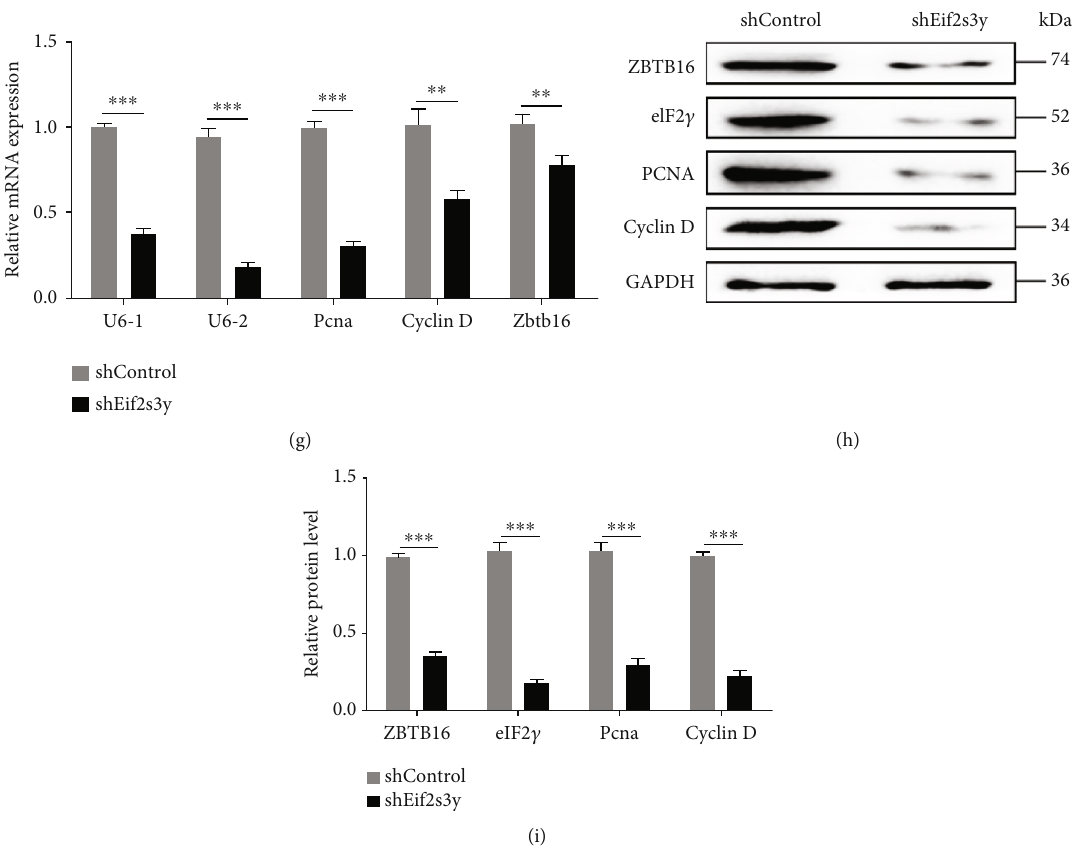
Figure 4: Depletion of Eif2s3y resulted in proliferation abnormality in goat SSCs. (a, b) The schematic of lentivirus plasmid CD513B-U6-MCS and CD513B-U6- shEif2s3y . (c) Typical images of shControl (left) and shEif2s3y (right) SSCs. Scale bar, 200 μ m. (d) Proliferation curve of shControl and shEif2s3y SSCs and the results of population doubling time (PDT) determination. (e) EdU incorporation assay of shControl (up) and shEif2s3y (down) SSCs. Scale bar, 400 μ m. (f) The ratio of EdU-positive cells to total cells. Data are presented as mean ± SD and are represented by three independent repetitions. (g) RT-PCR analysis of the expression levels of Eif2s3y , Pcna , Cyclin D, and Zbtb16 in shControl and shEif2s3y SSCs in vitro . (h) Western blotting detected the protein expression of ZBTB16, eIF2 γ , PCNA, and Cyclin D in shControl and shEif2s3y SSCs. GAPDH was used as a loading control. (i) Gray intensity analysis of WB results normalized to GAPDH in (h). Data are presented as mean ± SD and are represented by three independent repetitions; ∗ P < 0 : 05 , ∗∗ P < 0 : 01 , and ∗∗∗ P < 0 : 001